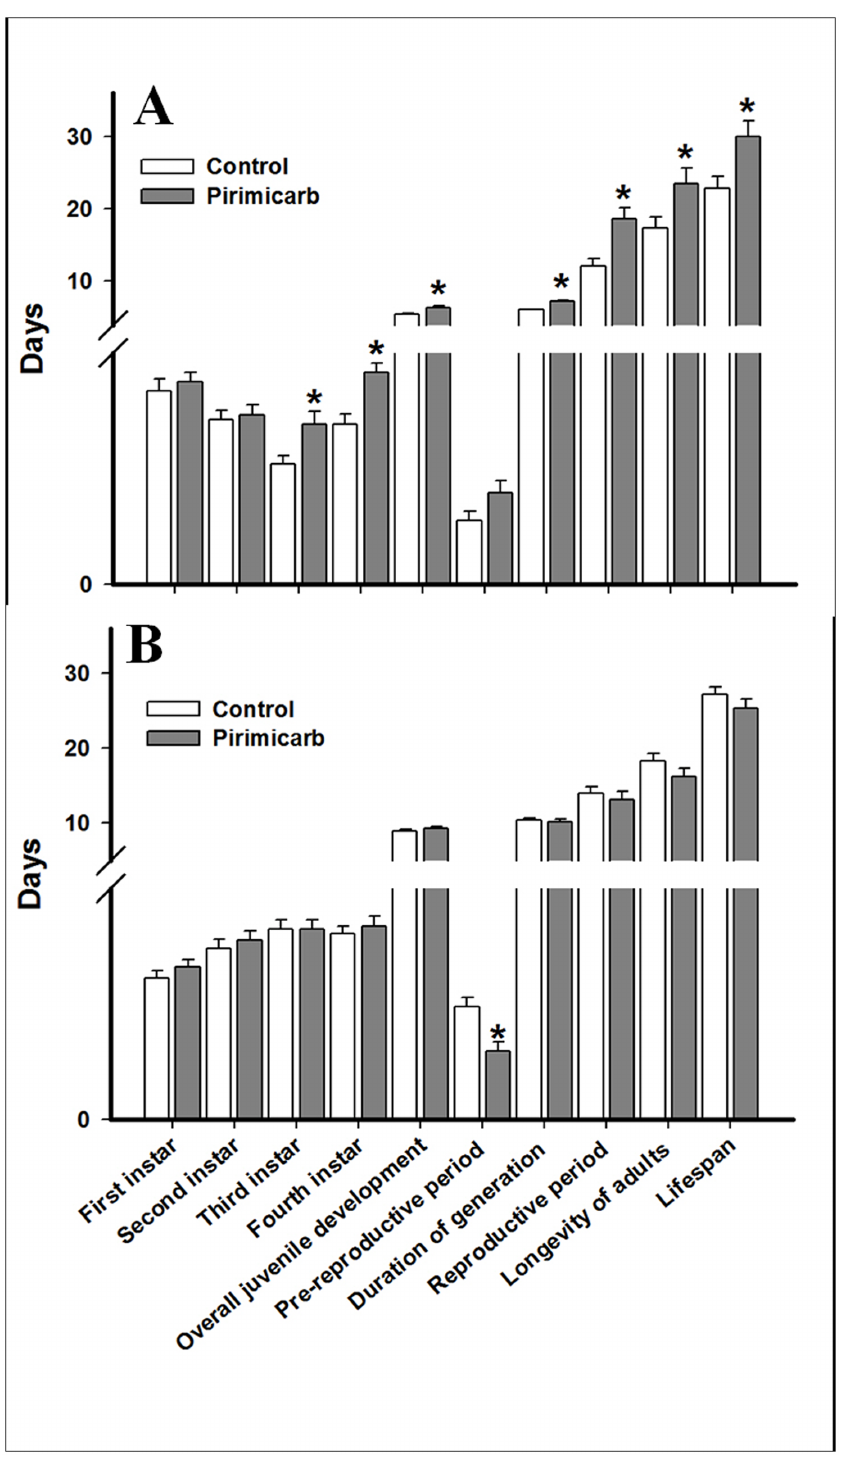
Fig 1. Effects of LC 25 of pirimicarb on biological traits of R . padi (A) and S . avenae (B) in the F1 generation. Asterisk on the bars of the histogram indicate significant differences between treatment and respective control (t-test) at P <